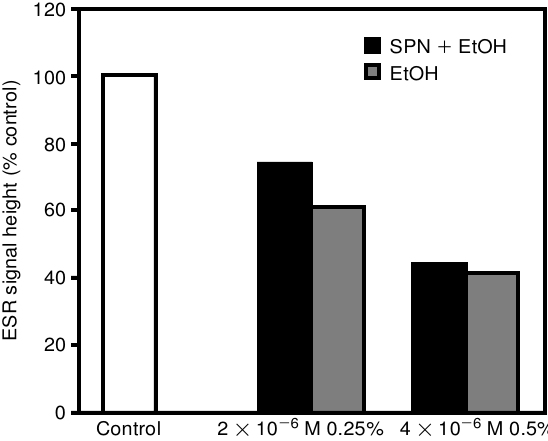
FIG. 4. The effects of sphingosine dissolved in ethanol (EtOH) and ethanol alone on ESR signal heights (DMPO 100 mM) by hydroxyl radicals generated by the Fenton reaction. [H 2 O 2 (88 mM), Fe 2 + (0.01 mM), EDTA (0.01 mM).] Sphingosine was added at two concentrations (2 and 4 3 10 - 6 M). Ethanol was used at 0.25 and 0.5%.